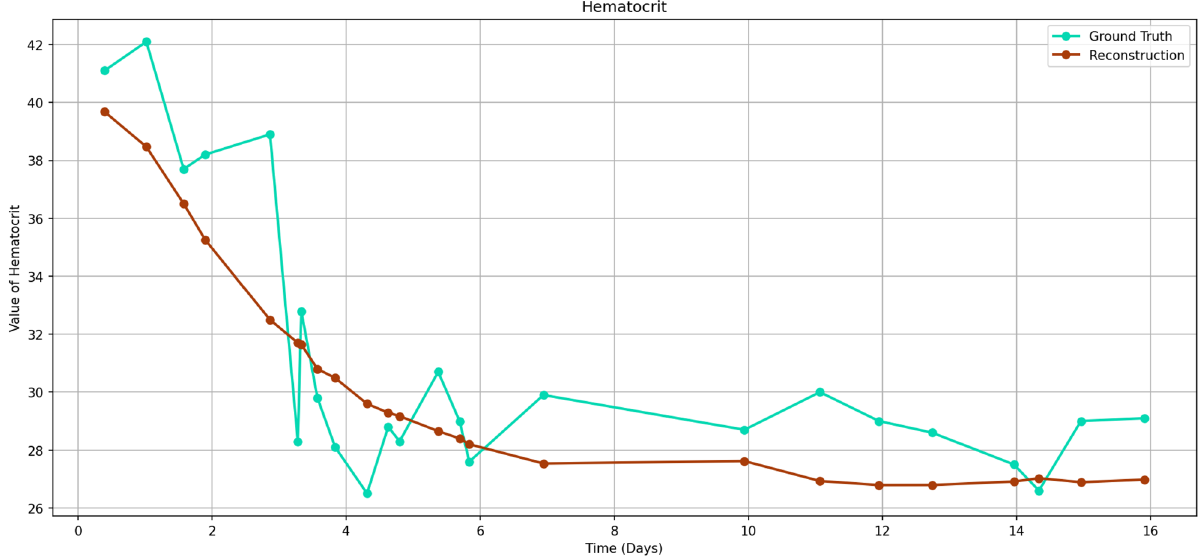
Figure 1. Reconstruction example for Hematocrit . The mean squared error (MSE) of this reconstruction is 0.23, which is representative of the model, which has a median reconstruction MSE of 0.25. Note how high-frequency movements (e.g., downward spike at around three days) are not reconstructed, but large-scale movements are. This indicates that the model has learned to grasp the “trend” of the time series, making the feature space used for reconstruction more meaningful.